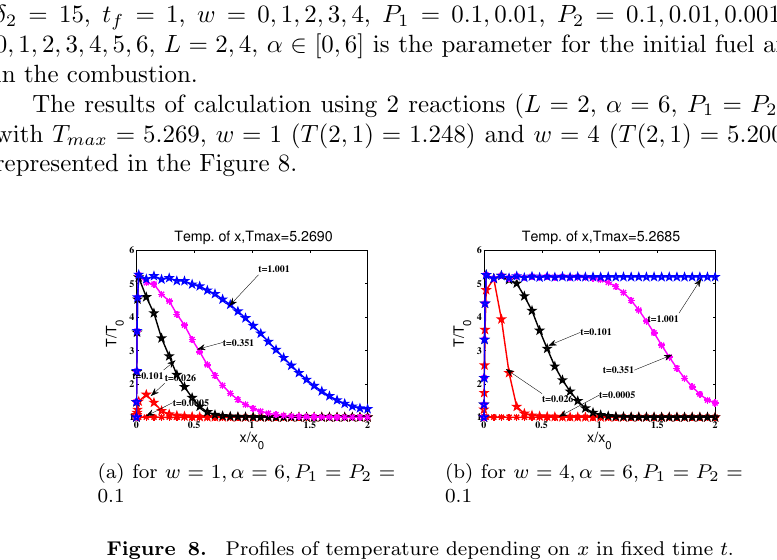
Figure 8. Profiles of temperature depending on x in fixed time t .